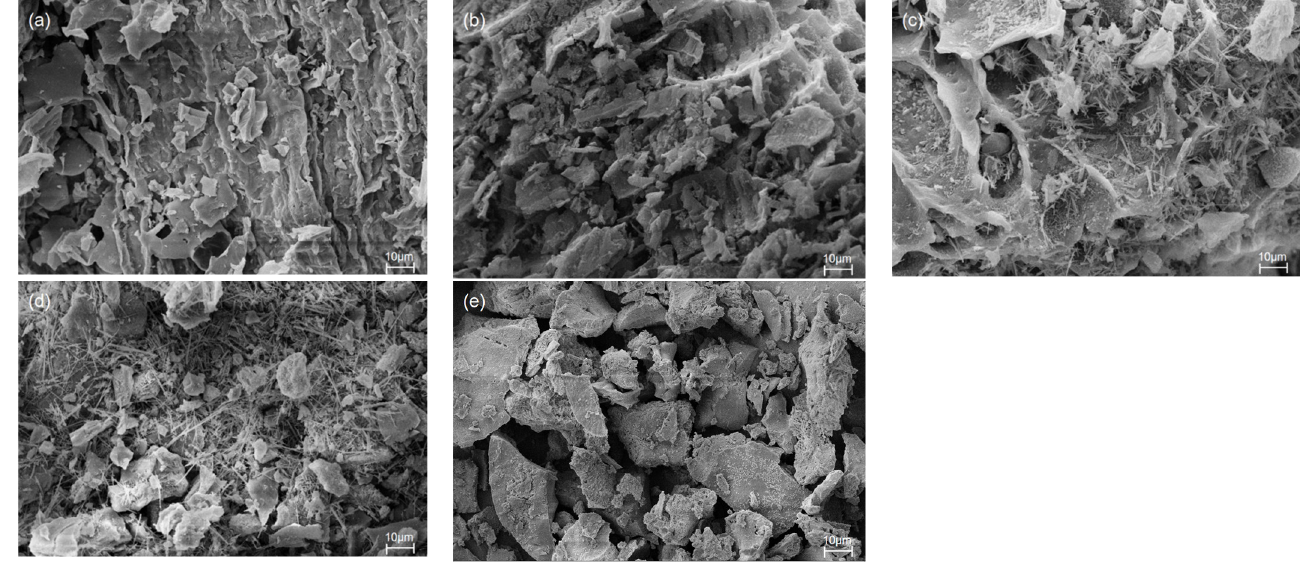
Figure 1. Scanning electron microscopy (SEM) images of BC ( a ), 5%Mg-BC ( b ), 10%Mg-BC ( c ), 15%Mg-BC ( d ) and 20%Mg-BC ( e ).